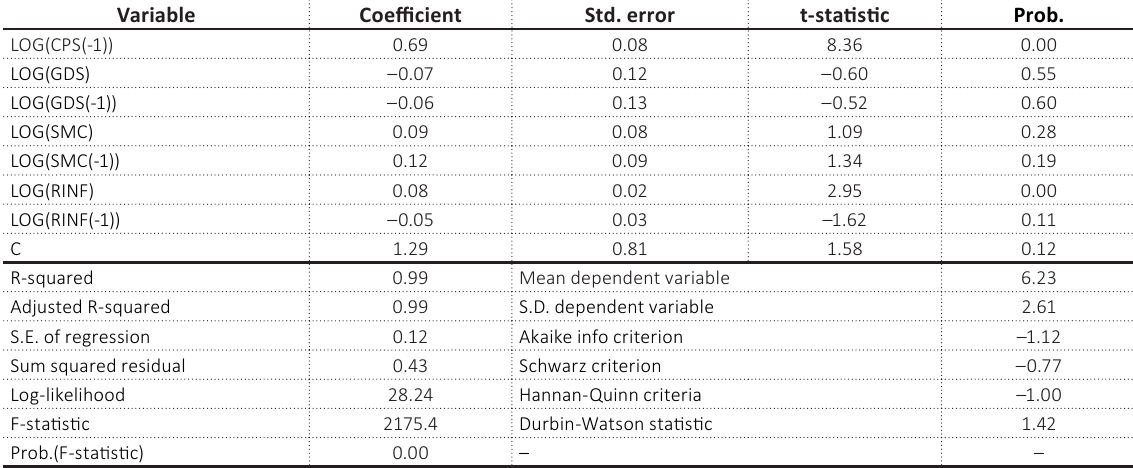
Table 4. ARDL model for credit to private sector and growth finance indicators